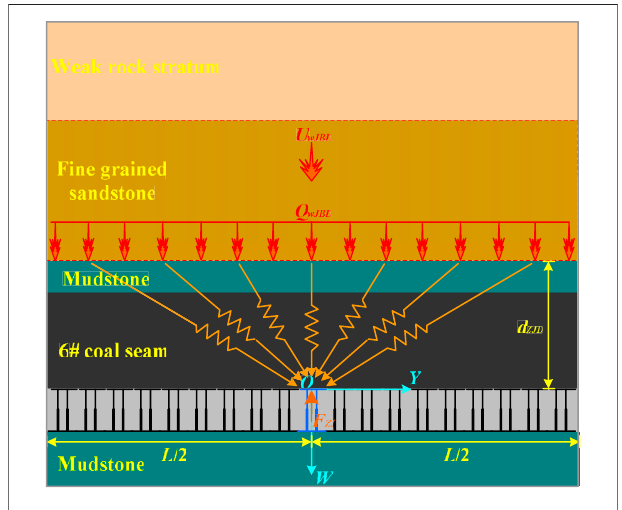
FIGURE 9 | Schematic diagram of the hydraulic support in the middle of the working face affected by impact dynamic load superposition.